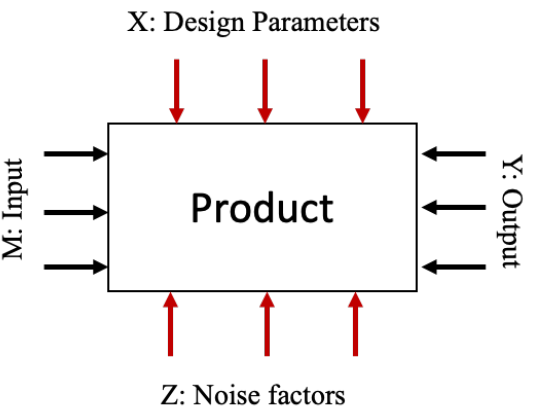
Figure 4. P-diagram. A P-diagram is used to classify the variables associated with the product into input energy, signal or user intent (M), noise factors (Z), design parameters (X) and output/key product characteristics, functions, performance, etc. (Y).